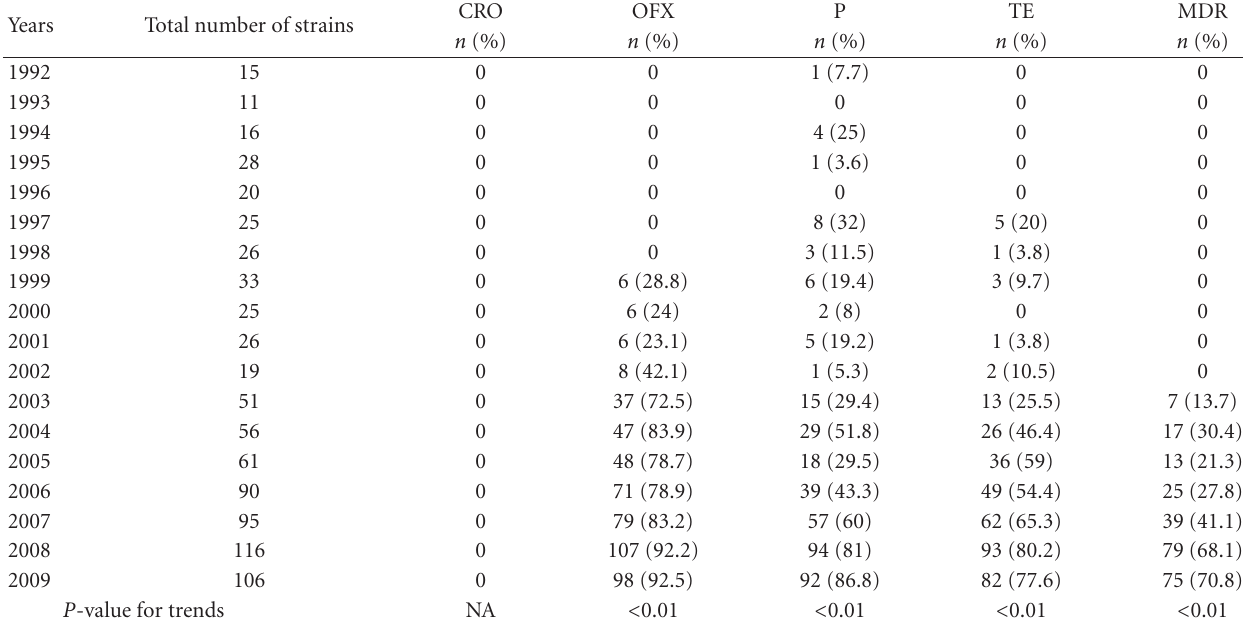
Table 1: Antimicrobial resistance trends in Neisseria gonorrhoeae strains over the years 1992–2009 showing significant increase in resistance to penicillin, tetracycline, and ofloxacin. There is also significant increase in combined resistance to all 3 antibiotics. n is the total number of resistance strains for that particular year. Percentage is shown in parenthesis (%).